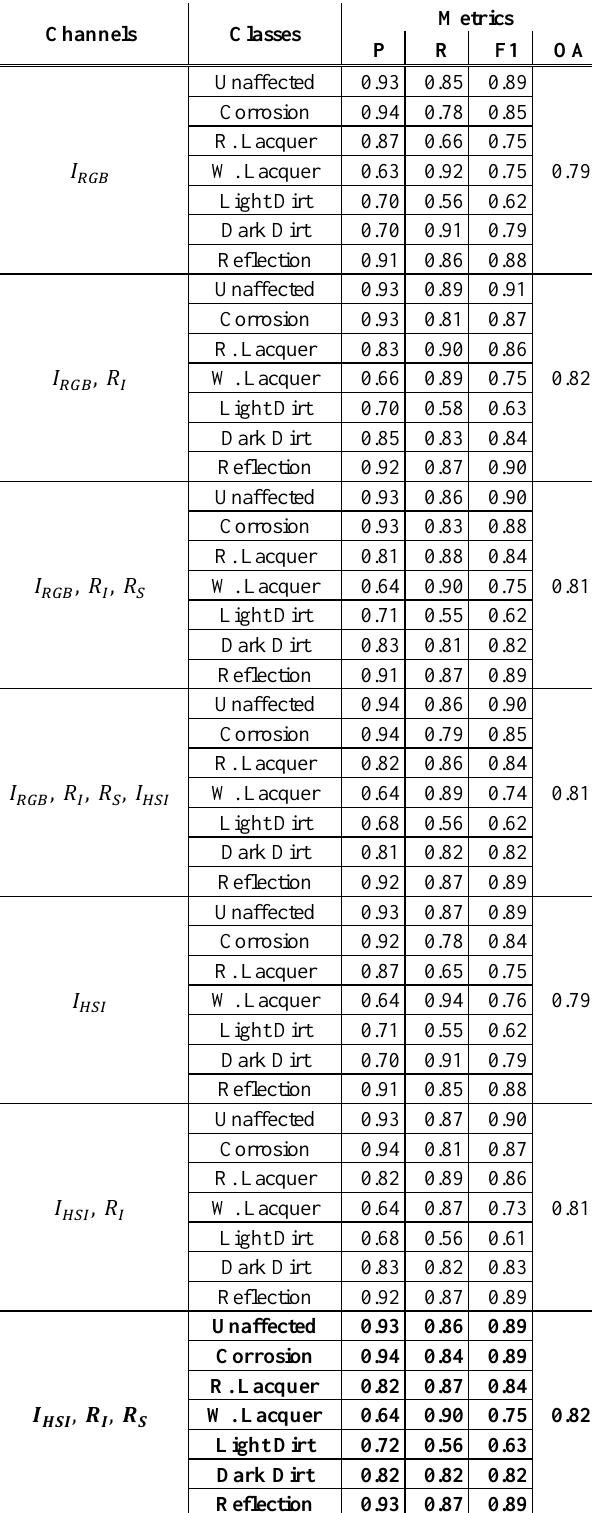
Table 1. Evaluation metrics for the classification of seven classes for each channel-combination. The metrics are precision (P), recall (R), f1-Score (F1) and overall accuracy